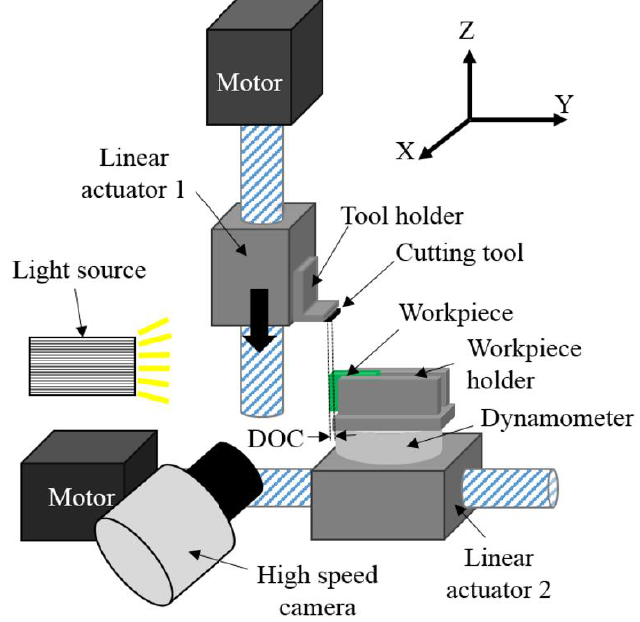
Figure 6. Schematic of the orthogonal cutting setup for model validation.